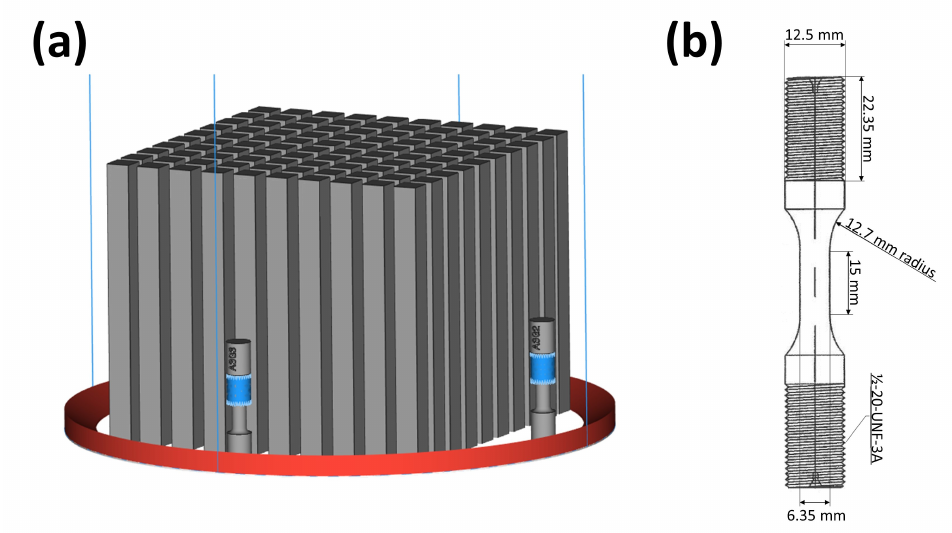
Figure 1. ( a ) Build layout in the Q20 machine’s cylindrical build chamber. The smaller objects in the build chamber are tensile test specimens for quality control. ( b ) Fatigue specimen